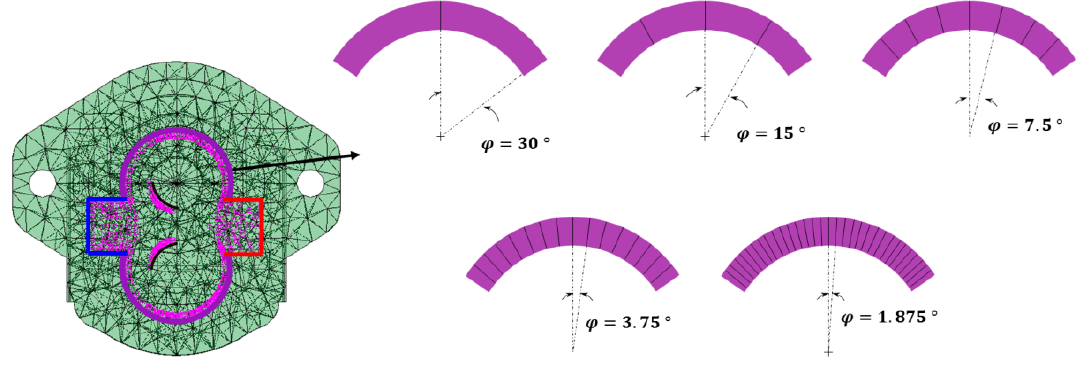
Figure 17. Overview of the sensitivity study for the determination of the angular interval for discretization of TSV pressure region.